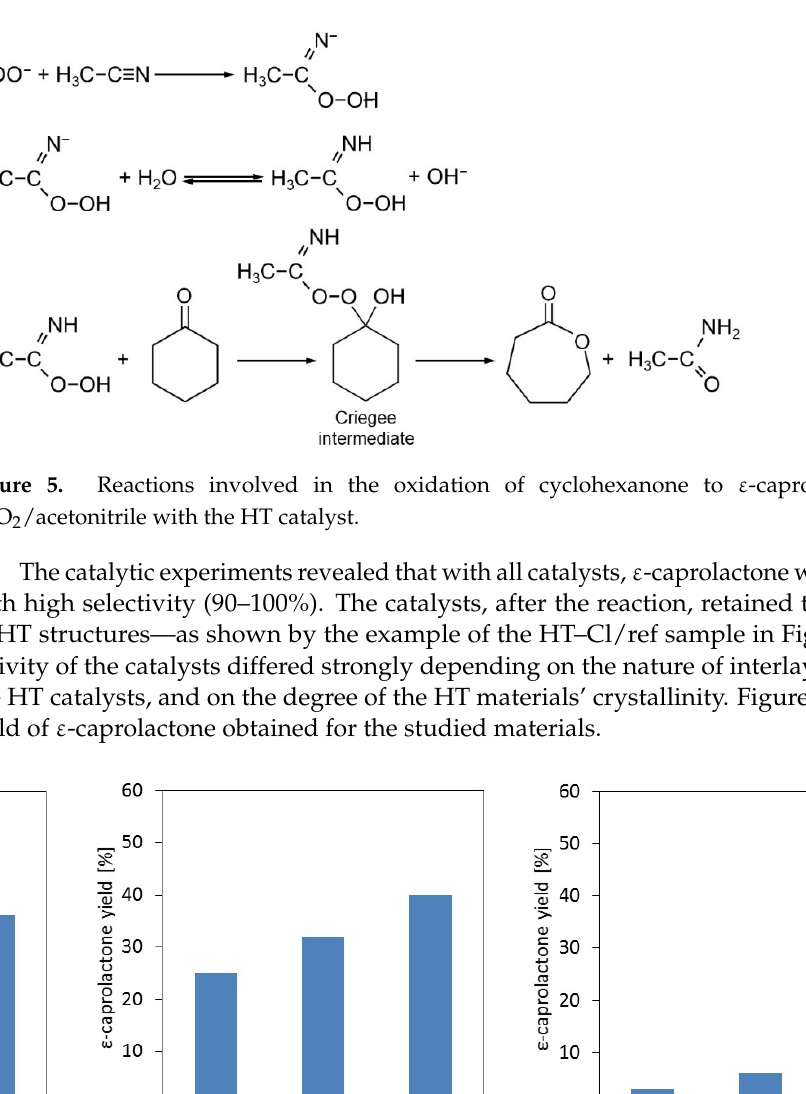
Figure 4. SEM micrographs of: ( a ) HT–Cl/im; ( b ) HT–Cl/s; ( c ) HT–Cl-ref.